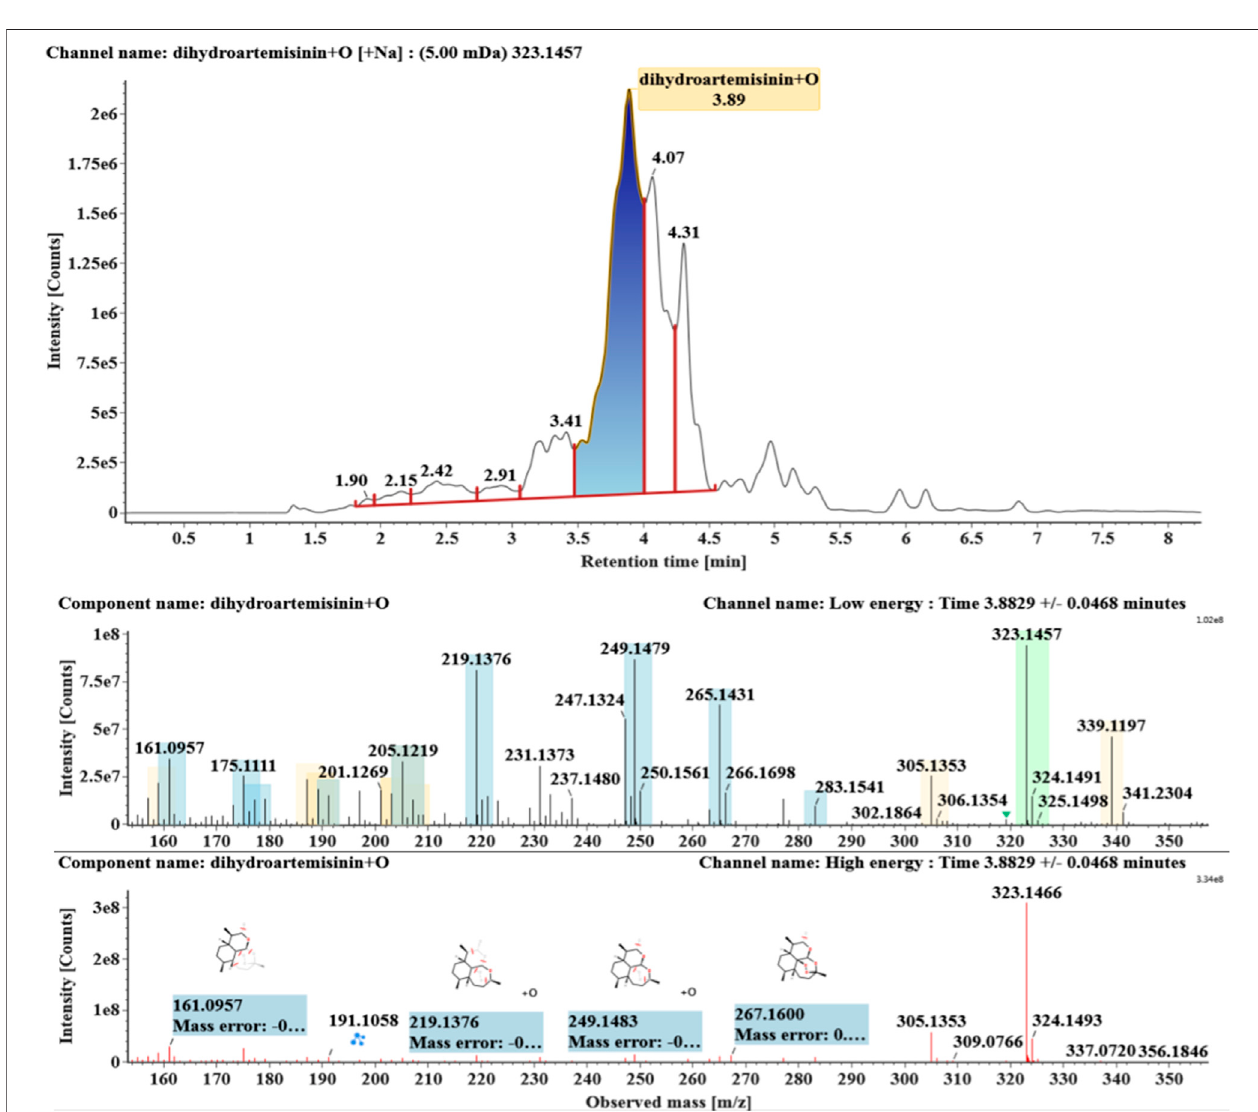
FIGURE 2 | Extracted ion chromatograms and mass spectrometry (MS E ) spectra of M1 .